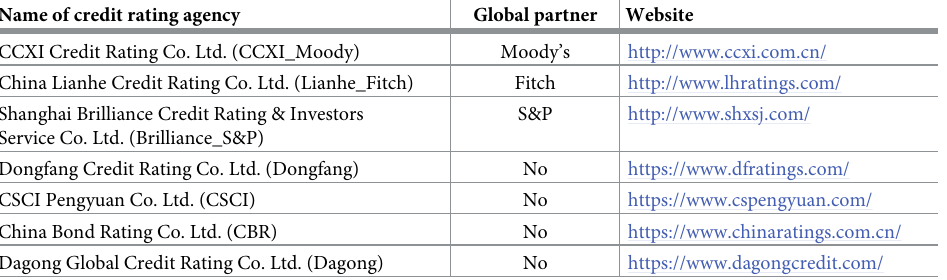
Table 1. List of credit rating agencies. This table presents the basic information about credit rating agencies in China’s local government bond